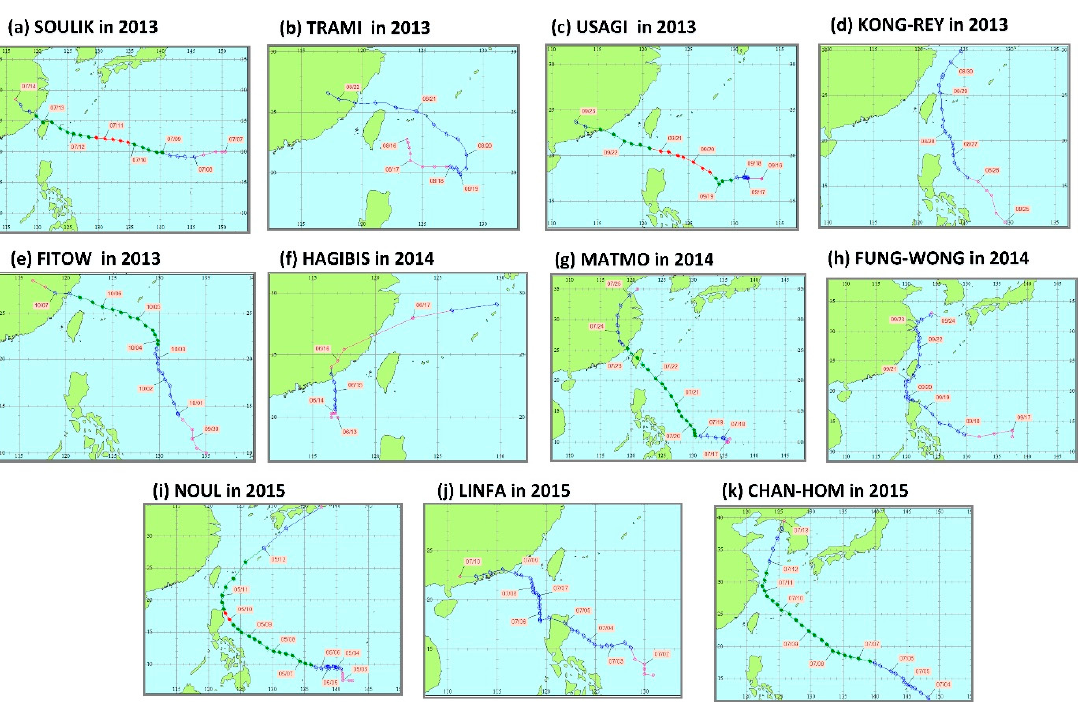
Figure 2. Paths of the 11 typhoons in the testing set: ( a ) Soulik in 2013; ( b ) Trami in 2013; ( c ) Kong-Rey in 2013; ( d ) Usagi in 2013; ( e ) Fitow in 2013; ( f ) Hagibis in 2014; ( g ) Matmo in 2014; ( h ) Fung-Wong in 2014; ( i ) Noul in 2015; ( j ) Linfa in 2015; and ( k ) Chan-Hom in 2015.